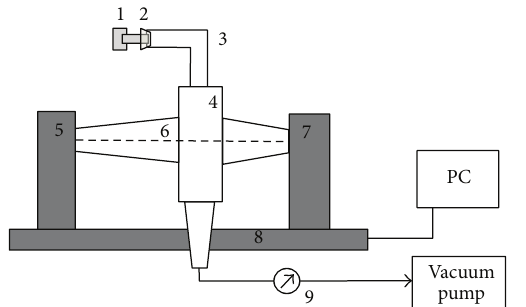
Figure 1: The experimental set-up for determination of particle size distributionofaerosolizedpowder:1:inhaler,2:adapter,3:USPinlet, 4: inhalation chamber, 5: laser emitter of Spraytec spectrometer, 6: laser beam, 7: laser detector of Spraytec spectrometer, 8: optical bench, and 9: valve and air